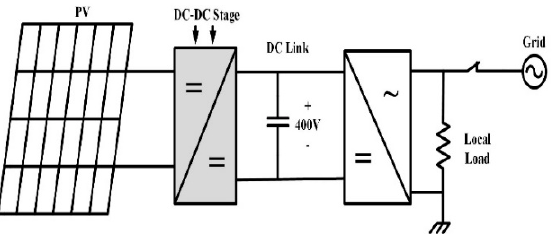
Figure 1. A converter’s role in renewable energy systems.